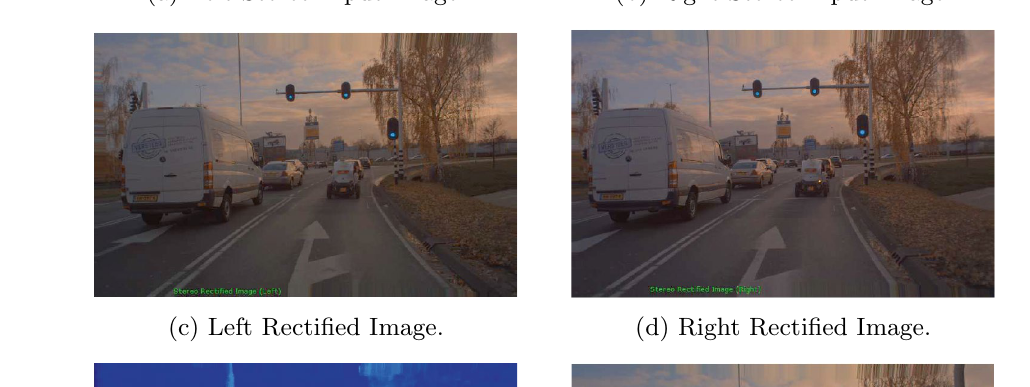
adjacent-lane, red for left ego-lane, green for right ego- lane, and blue for the right adjacent-lane. The identified drivable free space on the road and obstacles classifica- tion are displayed as free space boundary points. The boundary separates the obstacle from open road space. Each pixel on the boundary is associated with one of the four semantic labels: red for a vehicle, blue for a pedes- trian, green for a curb and yellow other.